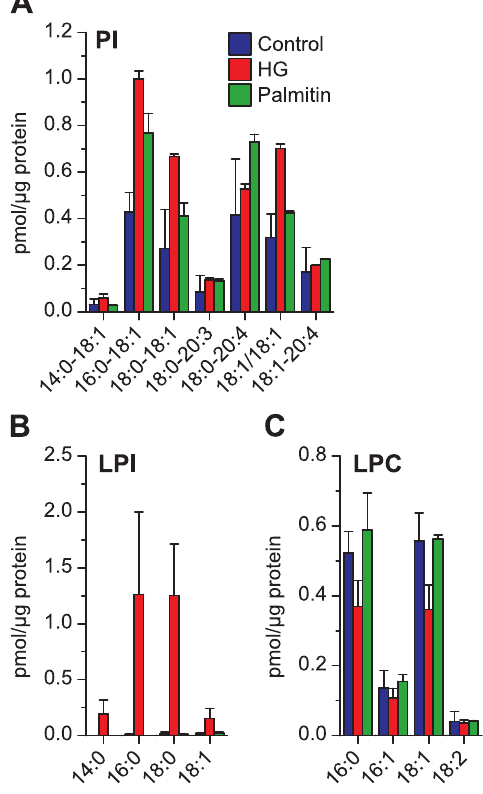
Figure 5. Quantitative analysis of phosphoinositide lipids and LPC after HG or palmitin treatment. The major species of ( A ) PI, ( B ) LPI, and ( C ) LPC in HEp-2 cells treated with HG (20 m M), palmitin (20 m M) or ethanol (0.1%, as control) for 24 hours. The species shown here are species comprising more than 2% of the total mass of the lipid class for at least one of the samples.